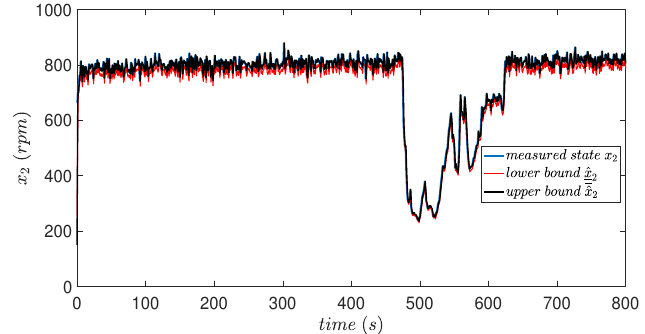
Figure 3. Measurement of rotational speed x 2 ( k ) and estimation of interval bounds.